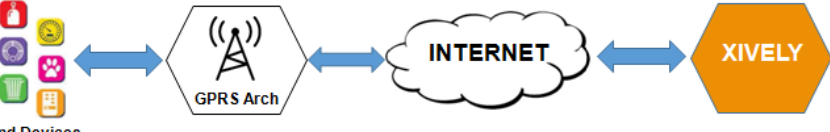
Figure 28. Illustration of the Xively